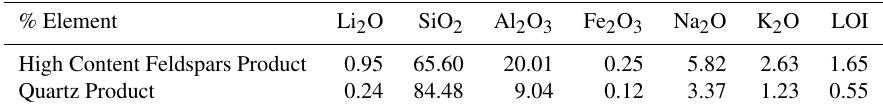
Table 2. Major elements analysis of the feldspars/quartz